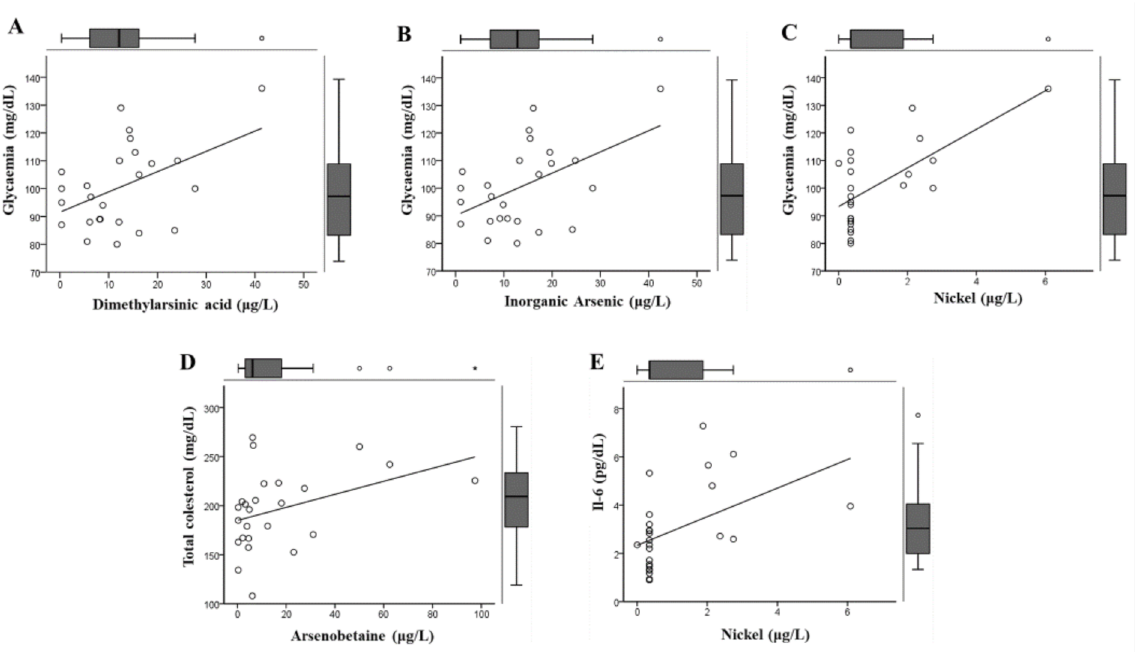
Figure 1. Significant correlations between biochemical and clinical parameters and levels of metals. The distributions of these parameters are shown using